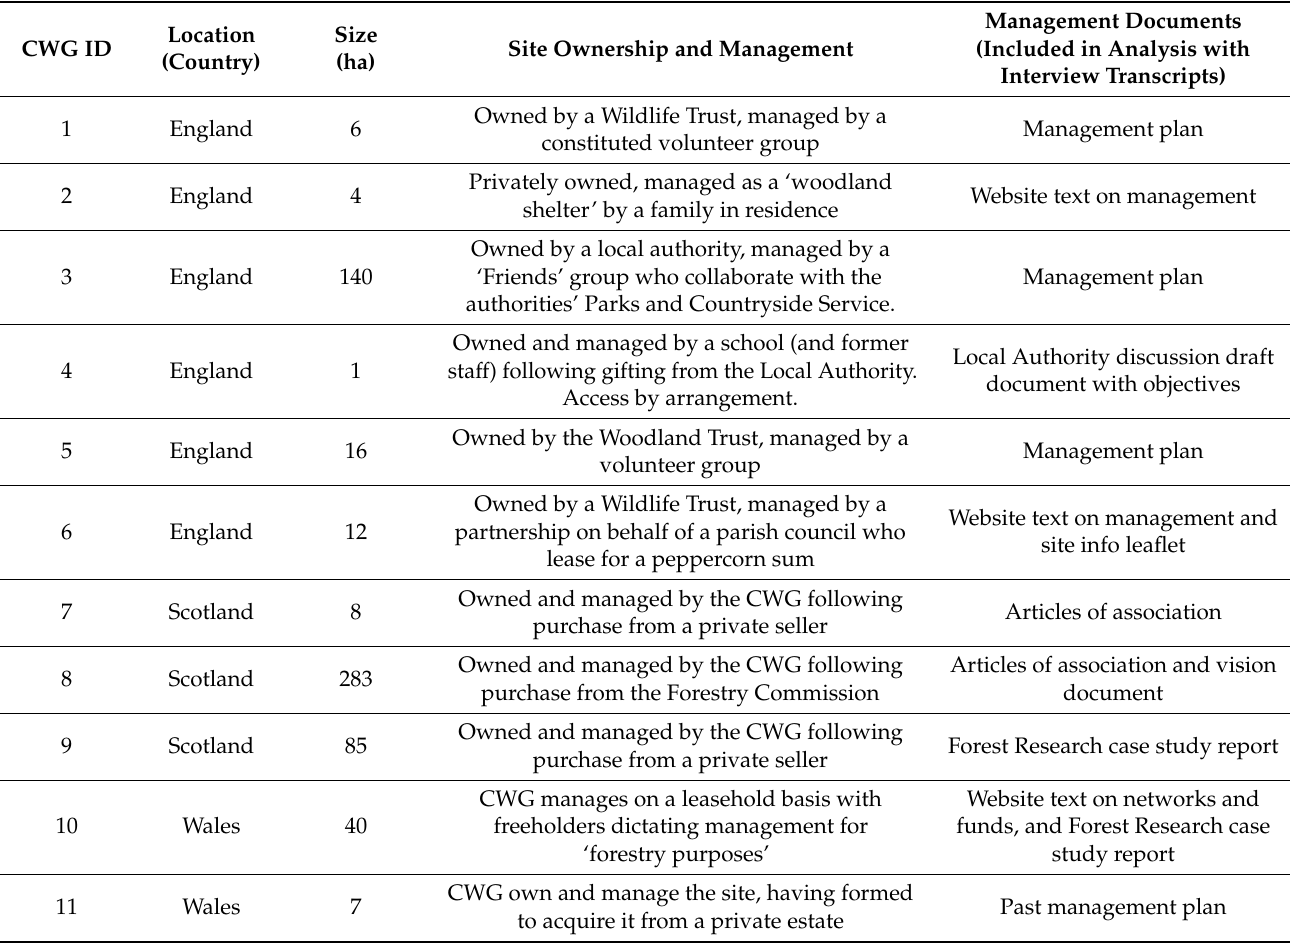
Table 1. Community Woodland Group Sample Characteristics.